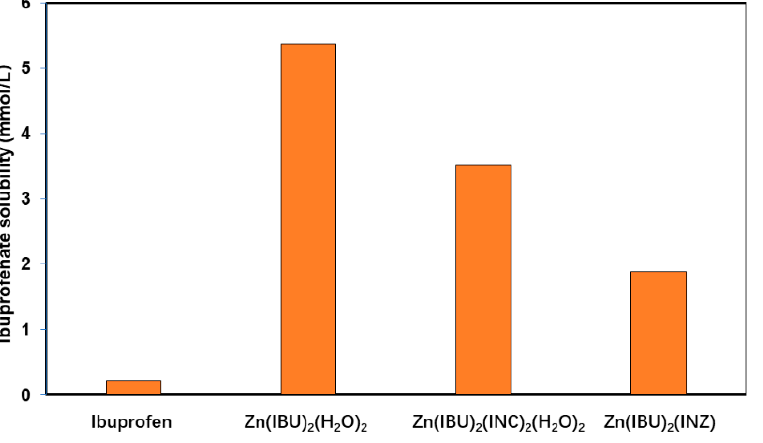
Figure 6. Solubility of ibuprofen, Zn(IBU) 2 (H 2 O) 2 , Zn(IBU) 2 (INC) 2 (H 2 O) 2 , and Zn(IBU) 2 (INZ) calculated based on the amount of ibuprofenate.